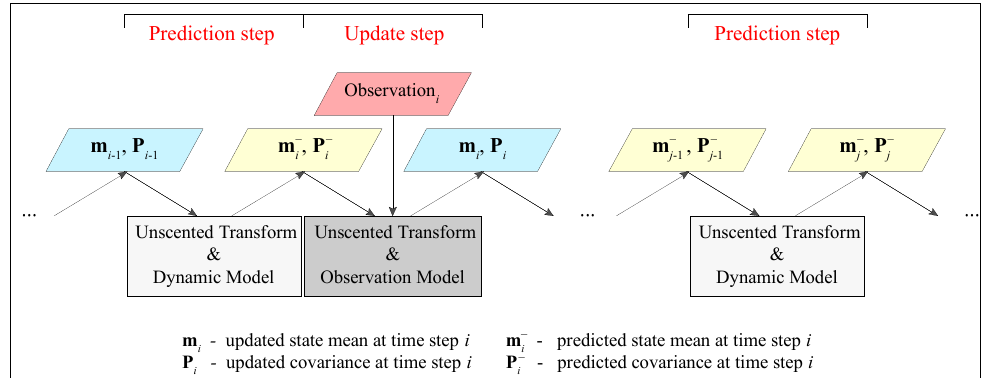
Figure 5. Schematic diagram of the unscented Kalman filter. The UKF addresses nonlinear problems by using a deterministic sampling